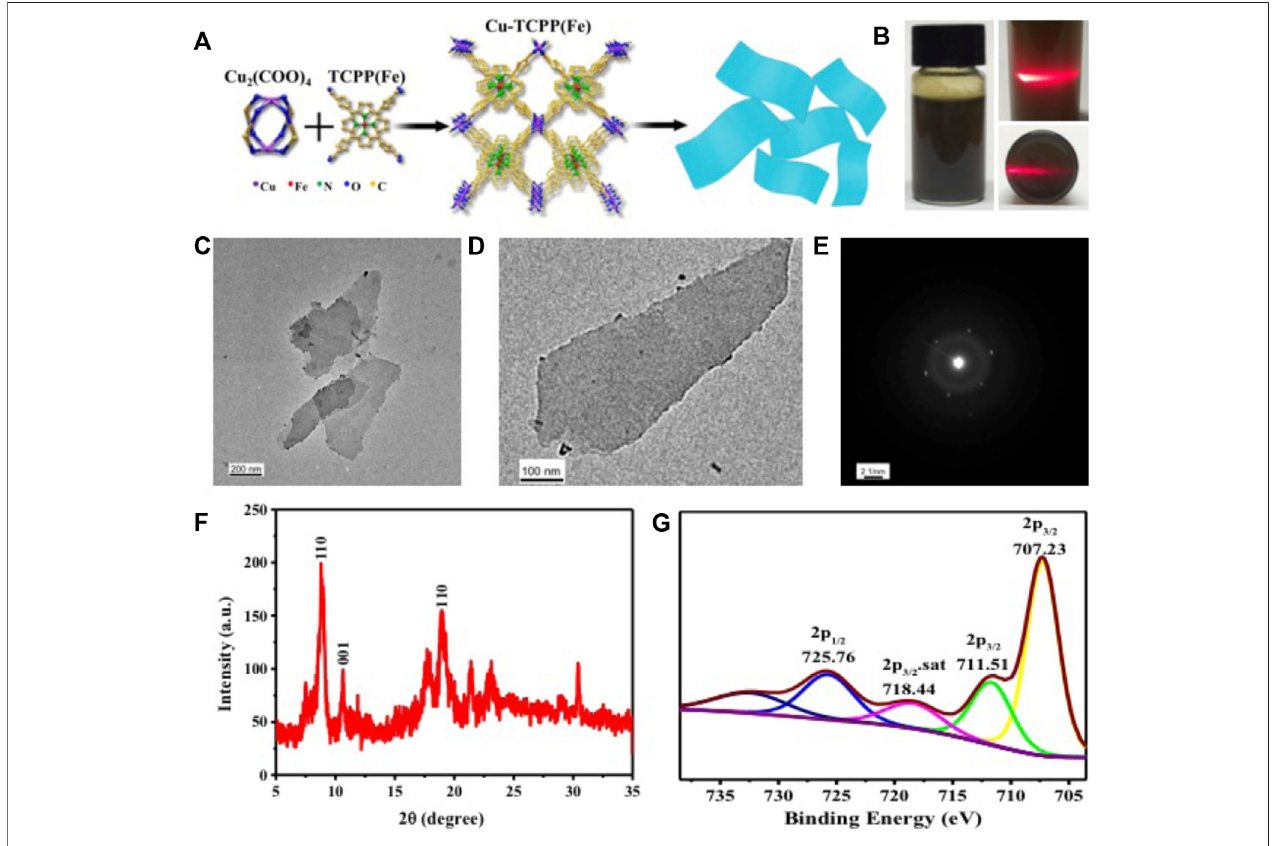
FIGURE 2 | Characterization of Cu-TCPP(Fe) MOFs. (A) A schematic showing the synthetic procedure for Cu-TCPP(Fe) MOFs. (B) A digital photograph and (C) TEMimageofCu-TCPP(Fe)MOFs. (D) ATEMimageand (E) SAEDpatternofatypicalCu-TCPP(Fe)MOF. (F) XRDpatterns,and (G) XPSspectraofCu-TCPP(Fe)MOFs.